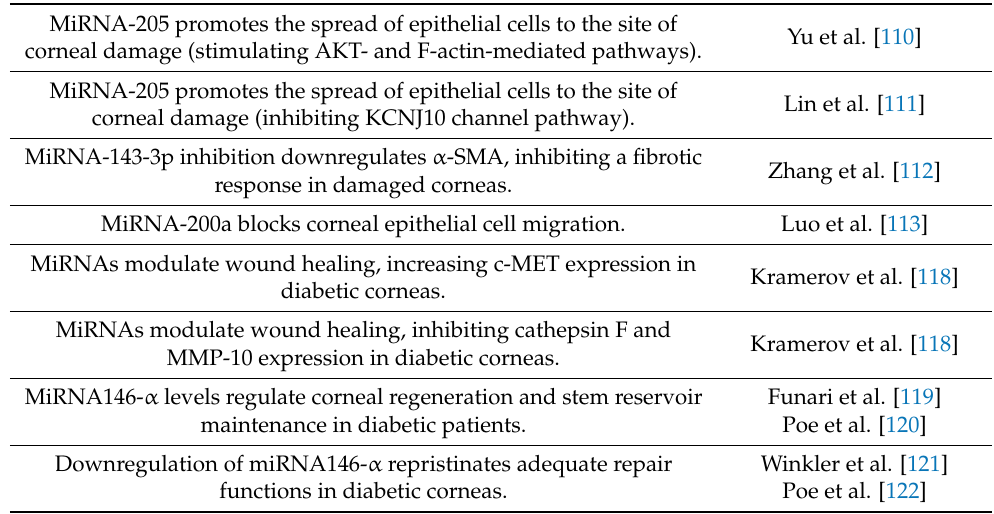
Yu et al. [110] Lin et al. [111] Zhang et al. [112] Kramerov et al. [118] Kramerov et al. [118] Funari et al. [119] Poe et al. [120] Winkler et al. [121] Poe et al. [122]